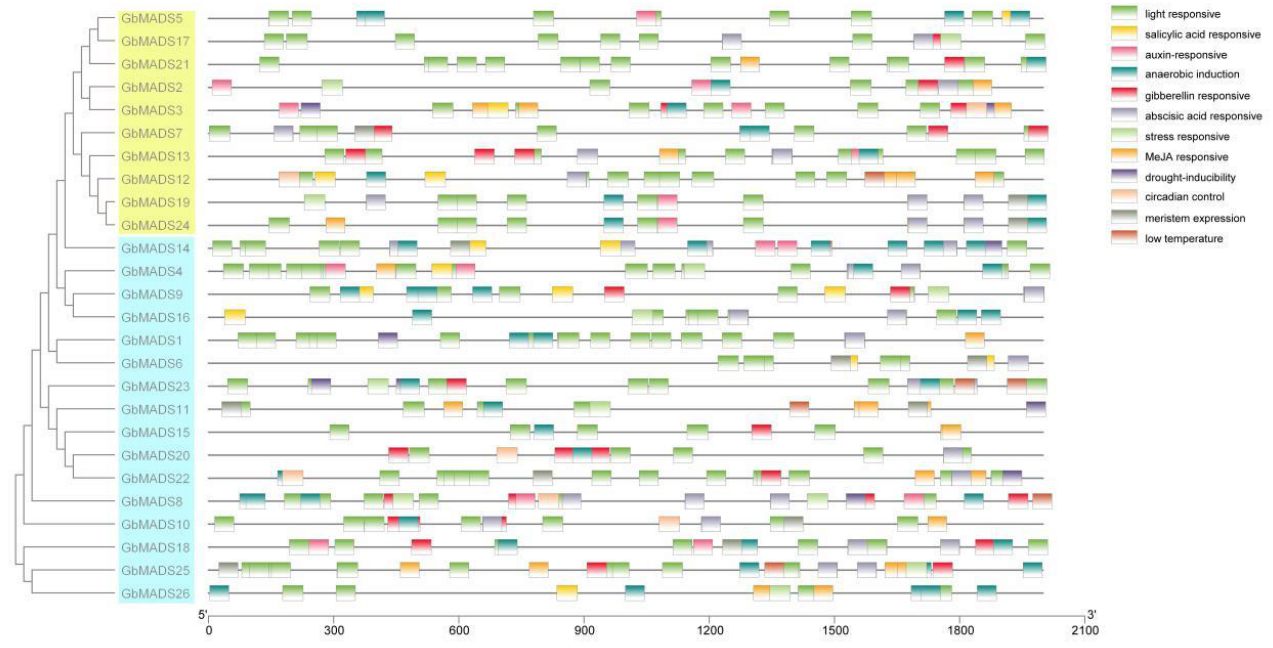
Figure 6. Promoter cis-acting elements of GbMADS gene family in G. biloba . In the phylogenetic tree constructed based on the full-length sequence of GbMADS proteins, the yellow background color was labeled with type-I GbMADS proteins, and the blue background color was labeled with type-II GbMADS proteins. Boxes of different colors represent different response elements. 3.7. Expression Profile Analysis of the GbMADS Genes in the Male and Female Flowers of G. biloba The expression patterns of the GbMADS genes in six stages of OS1, OS2, OS3, M1, M2, and M3 were shown in Figure S4. The results can be visualized as heat maps to show that GbMADS genes were expressed to varying degrees at different stages of flower development (Figure 7). GbMADS9 and GbMADS17 were highly expressed in the M2 phase, and GbMADS16 was much more highly expressed in the M1 and M2 phase than the other genes. As a member of the MIKC * branch in type-II, GbMADS16 may play a key role in male flower development. Except for GbMADS2 and GbMADS7 , the expression of the type-I GbMADS genes (yellow part) in the male flowers was higher than that in the female flowers. With the exception of GbMADS9 , GbMADS14 , and GbMADS16 , the expression of other type-II GbMADS genes in the female flowers was higher than that in the male flowers. These results show that there are differences in the expression level of GbMADS genes in the same gene family and even in the same